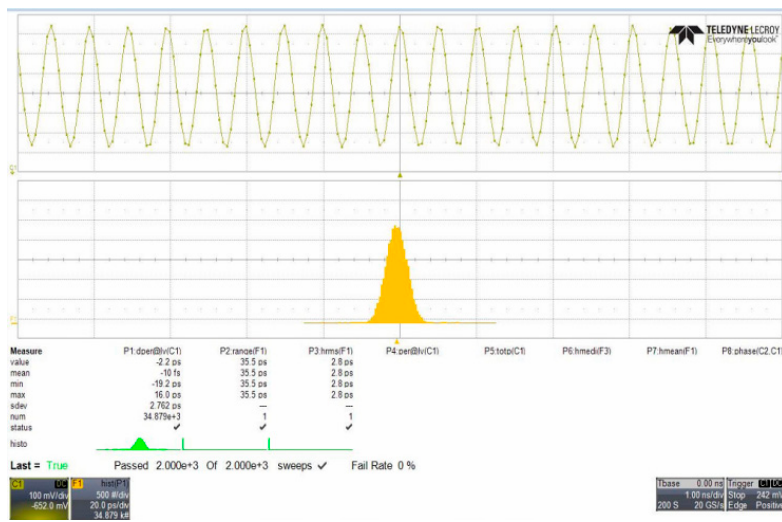
Figure 8. Peak-to-peak jitter and root mean square jitter of proposed VCO.